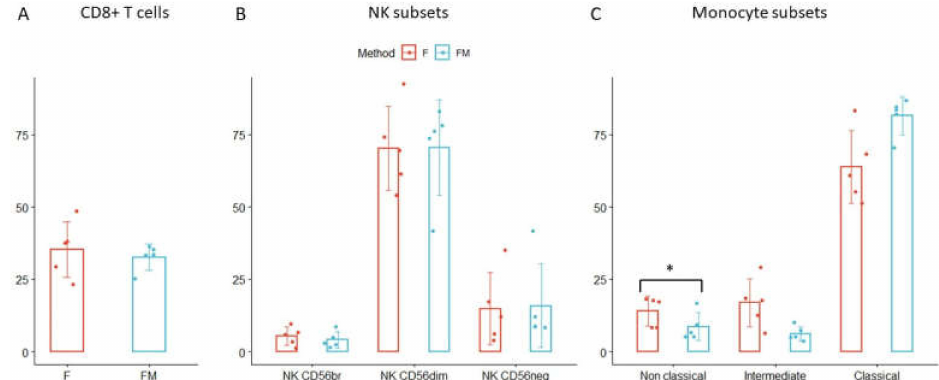
Figure 10. Comparison of cytotoxic T cells, NKs, and monocytes in FM treated and fresh samples. The comparison of cell frequency variation in fresh (F) and thawed samples treated with freezing mix (FM) method is shown. ( A ) CD8+ T cells, ( B ) NK subsets and ( C ) monocyte subsets were represented as mean values of five samples ± standard deviation. * p -values from the paired t -test <